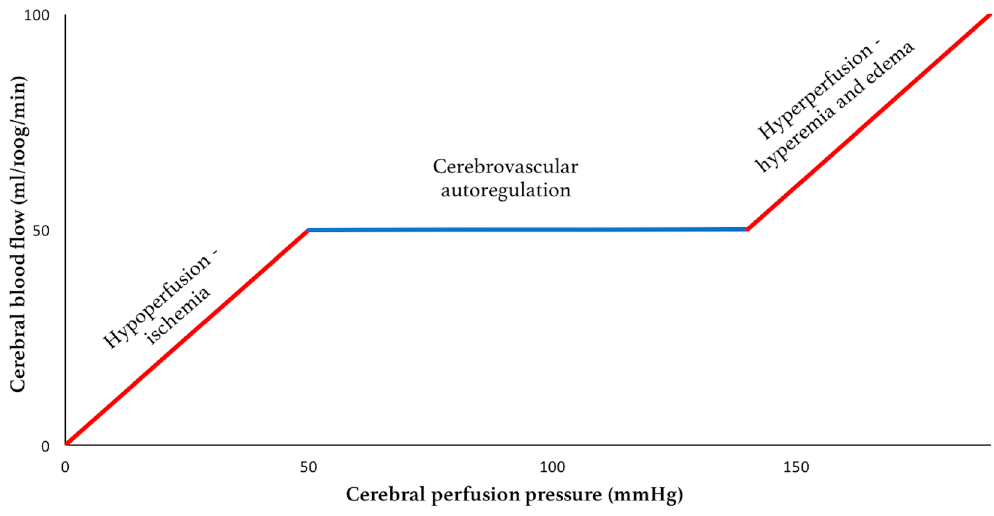
Figure 3. Cerebral autoregulation capacity.